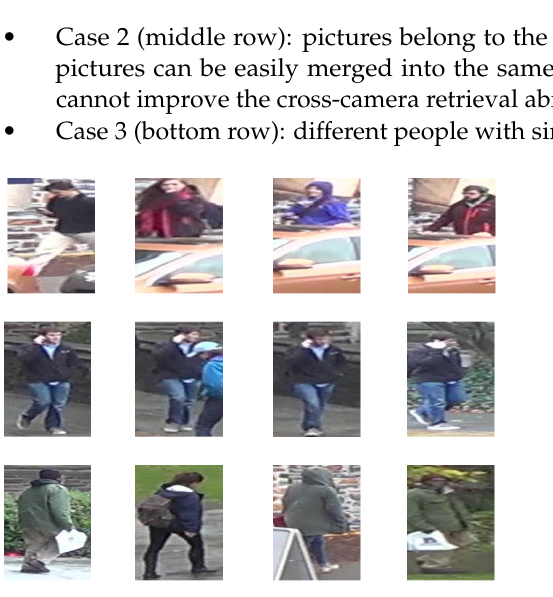
Figure 2. Cluster noise